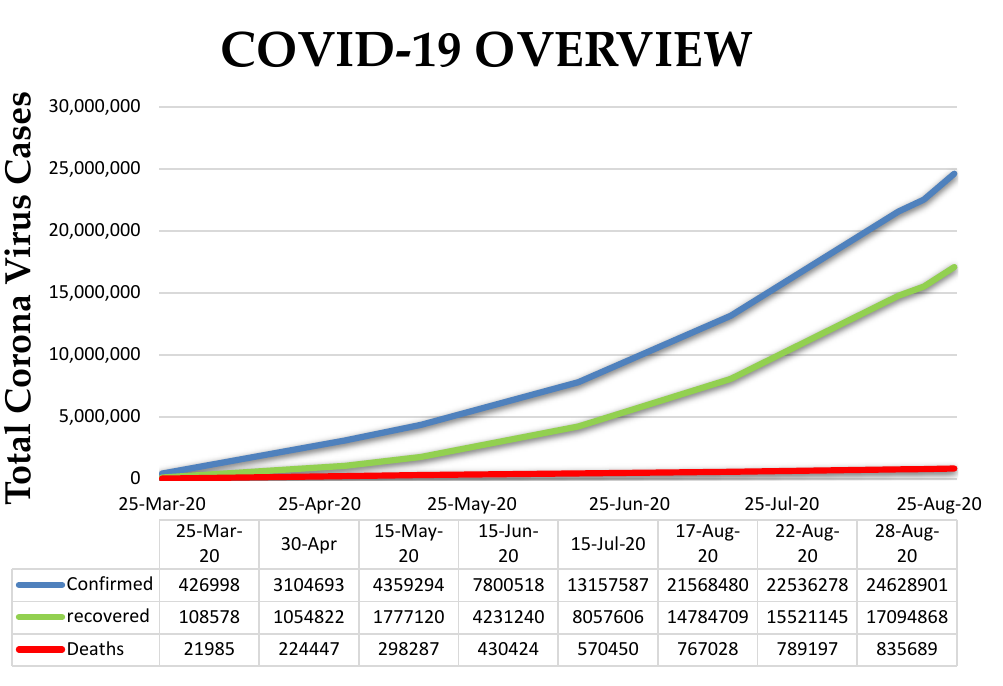
Figure 1. The rise in active cases of coronavirus [2] .